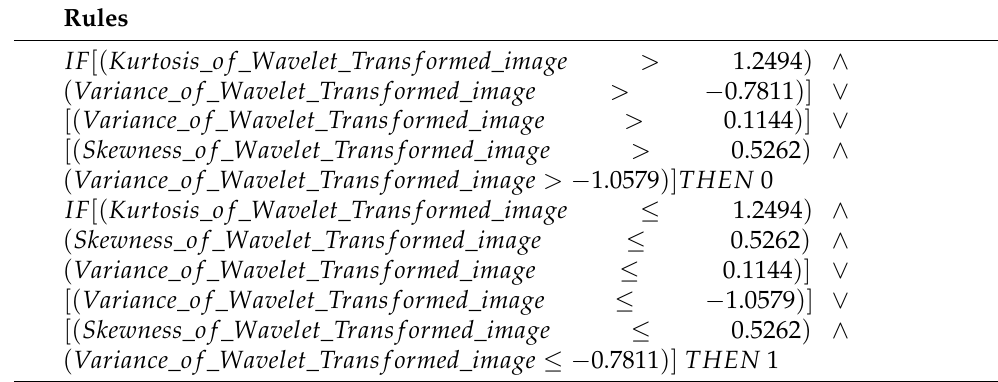
Table A12. Final rule set for the Banknote authentication dataset generated by